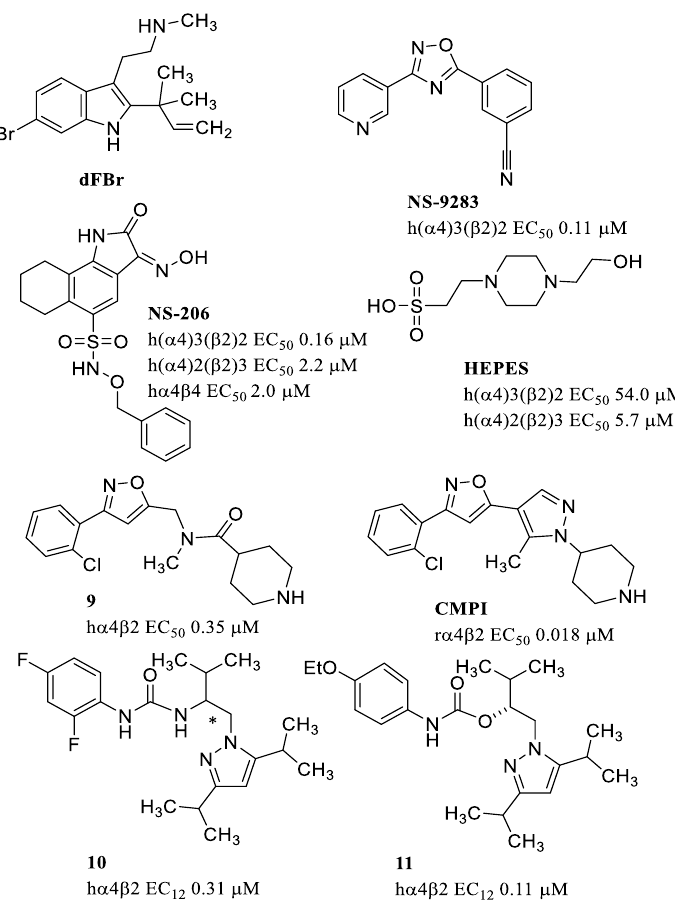
Figure 14. Allosteric modulators of the α4β2 nAChR.